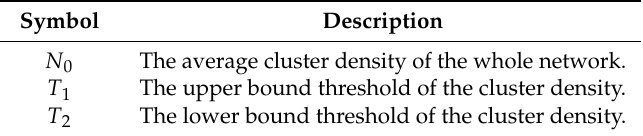
Table 2. Information table. RSSI: the received signal strength indicator; CH: a cluster head The ID of the CH